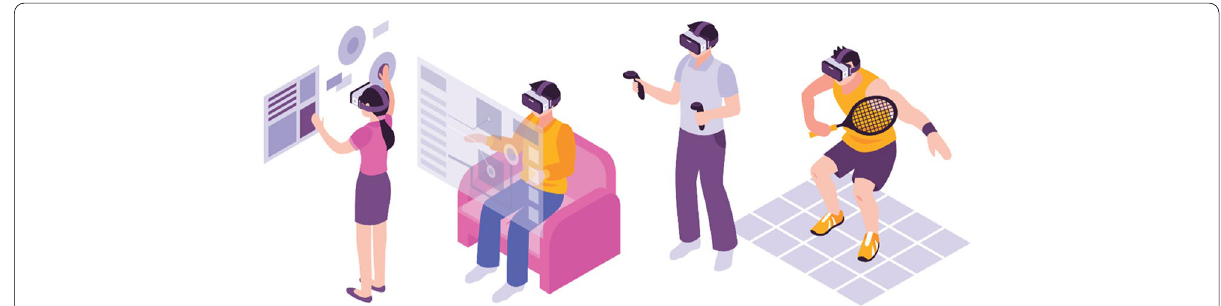
Fig. 2 Examples of VR deployment in everyday life, from communication, media use, and entertainment to